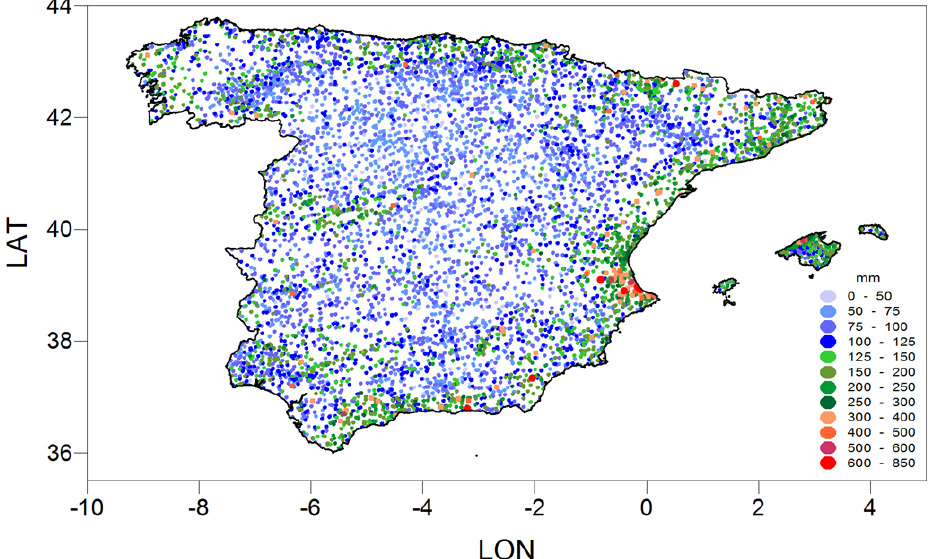
Fig. 3. Daily precipitation records for mainland Spain and Balearic Islands. Points show the locations of the rain gauge stations and colors indicate extreme precipitation amounts according to the scale.